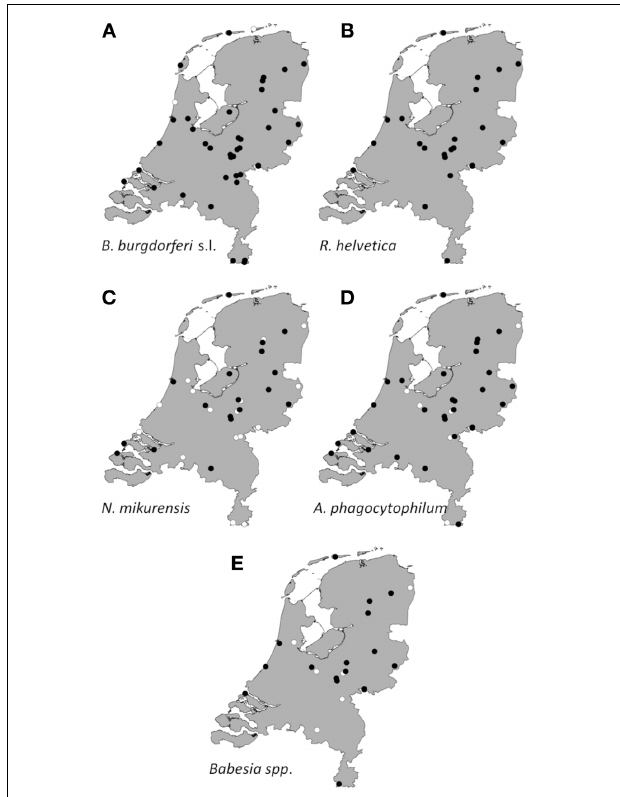
FIGURE 1 | Aggregated presence/absence map of questing I. ricinus nymphs/adults infected with B. burgdorferi s.l. (A), R. helvetica (B), N. mikurensis (C), A. phagocytophilum (D), Babesia species (E). The black dots represent presence of the microorganism; the white ones represent absence. Presence/absence points from previous studies were also